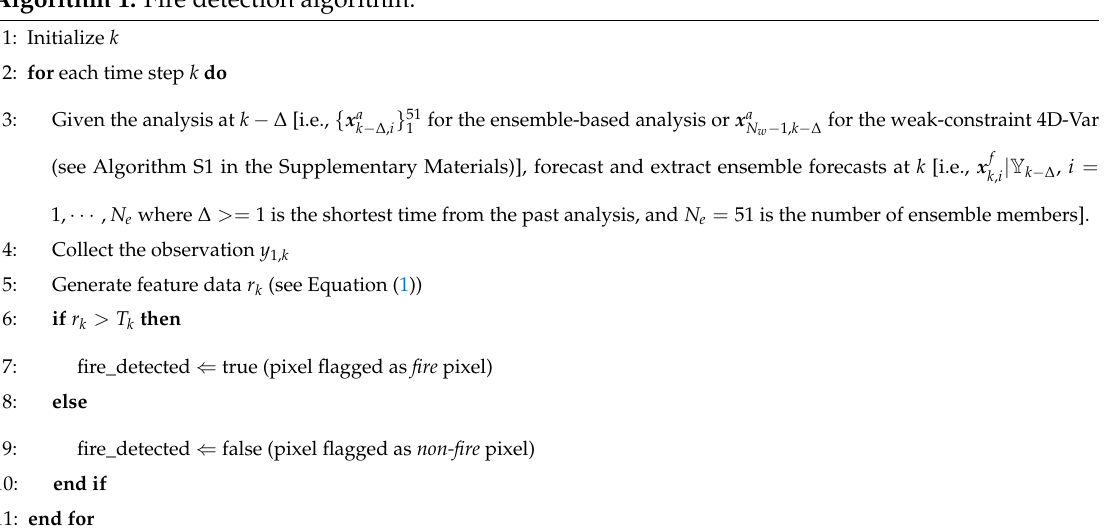
Algorithm 1. Fire detection